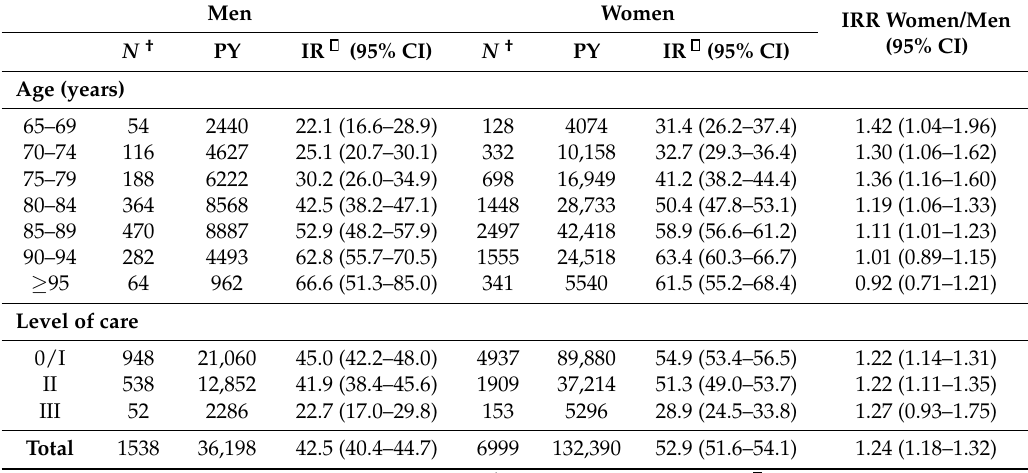
Table 1. Age- and level of care stratified hip fracture rates * in newly admitted nursing homes residents between 2010 and 2014, by sex.